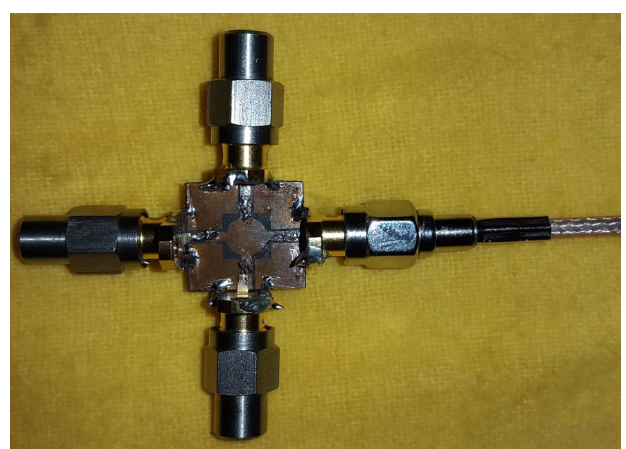
Figure 6: Fabricated prototype of the proposed antenna with pattern